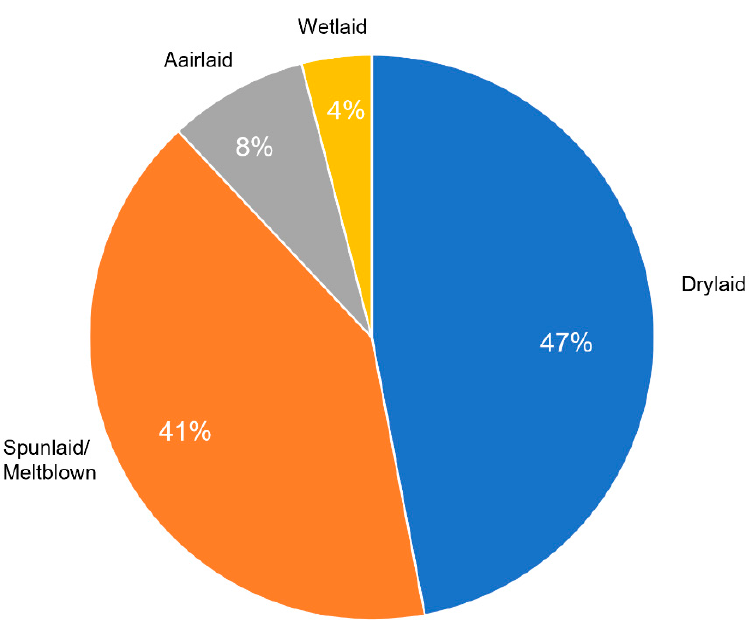
Figure 1. Repartition of worldwide production of nonwoven materials according to technologies [25].